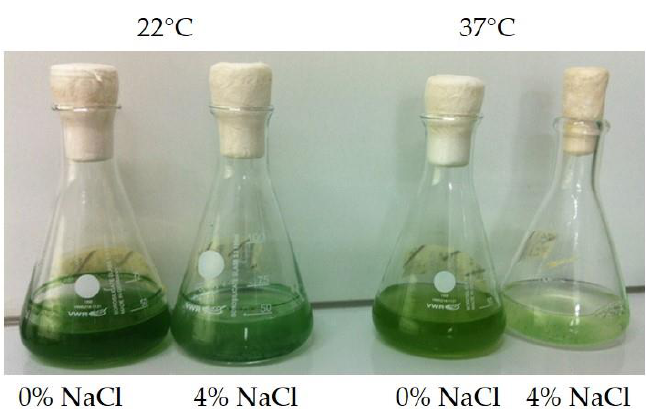
Figure 9. Synechocystis sp. IFA-3 inoculated in BG-I with and without NaCl at room temperature (22 °C) and elevated temperature (37 °C).